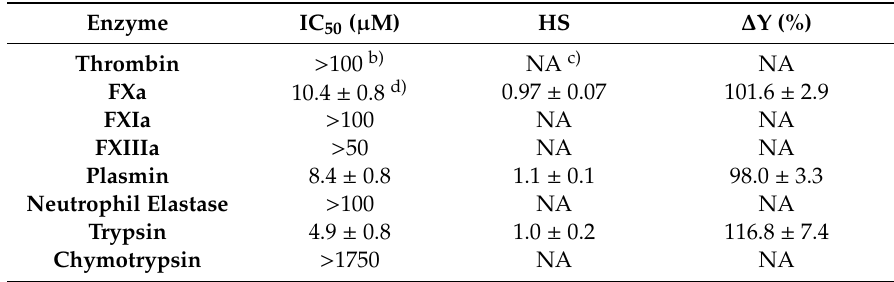
Table 2. The inhibition profile of pentamidine isethionate towards several enzymes of relevance to coagulation, inflammation, and digestion. a)